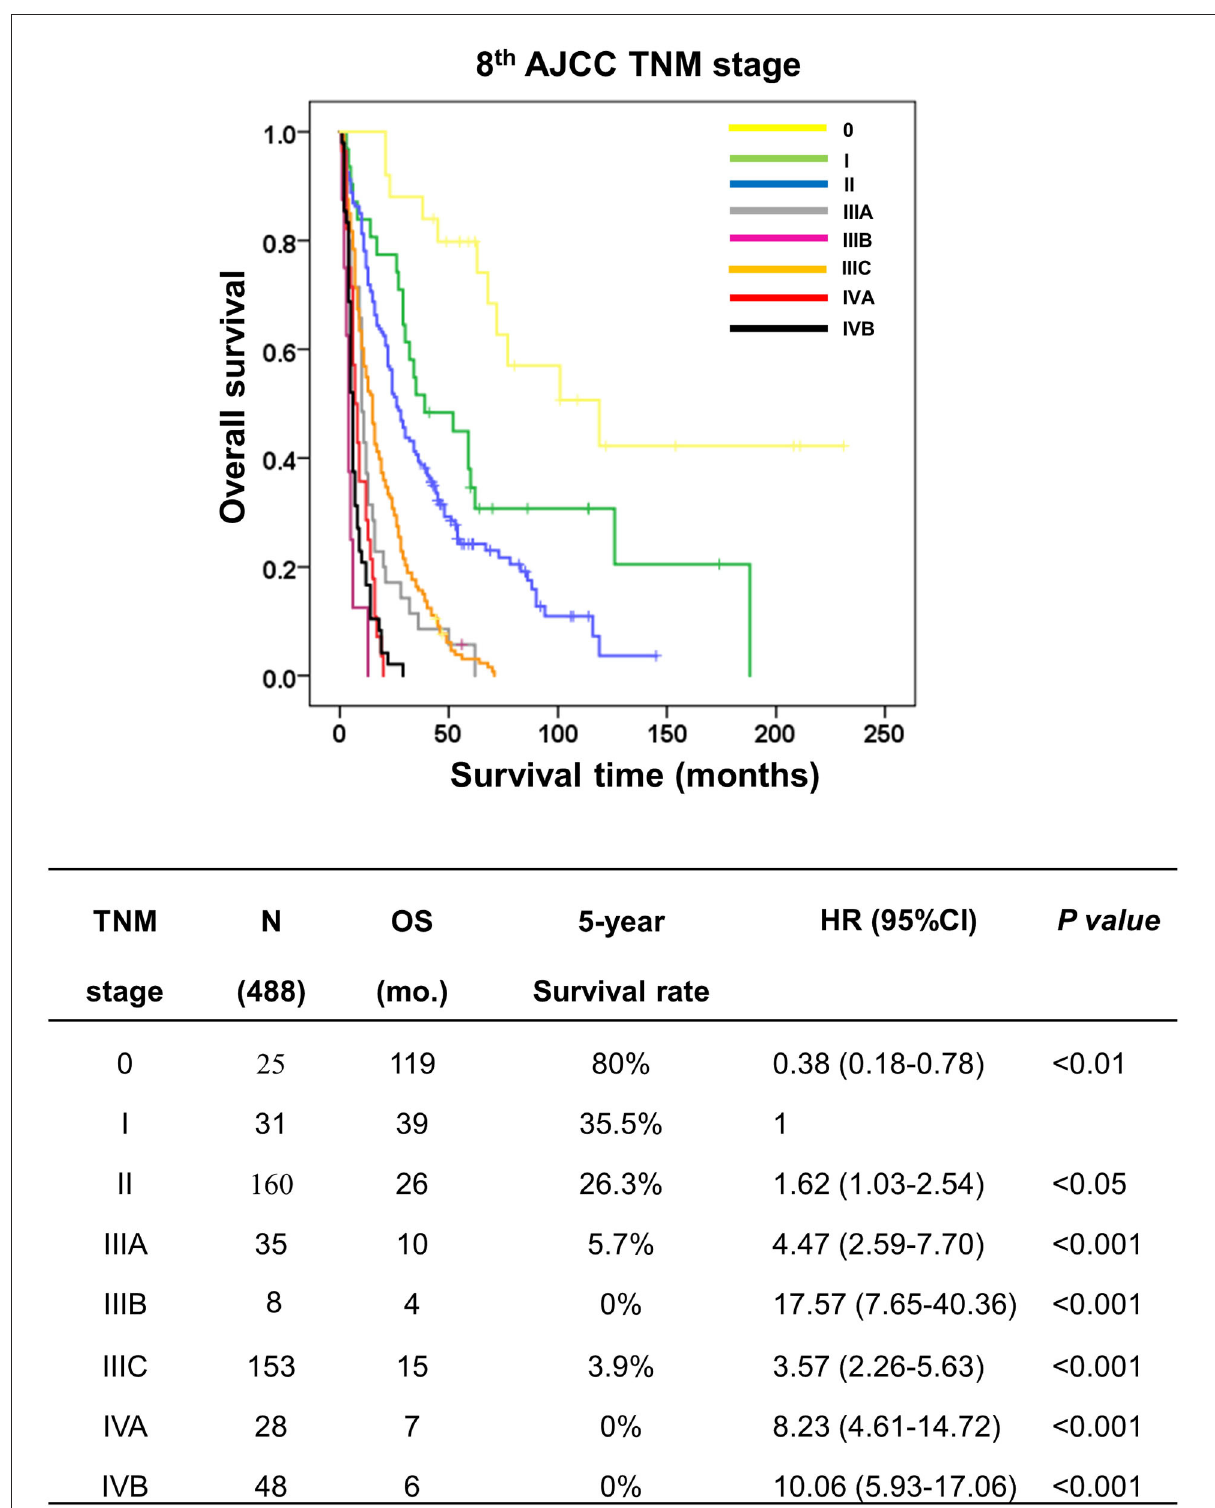
FIGURE3 Kaplan–Meier curve represented the overall survival of patients with perihilar cholangiocarcinoma with TNM stages by the eighth AJCC staging system. The table represented the outcomes of patients with TNM stage by the eighth AJCC staging system, namely, TNM stage, number of cases, overall survival, 5-year survival rate, hazard ratio, and p